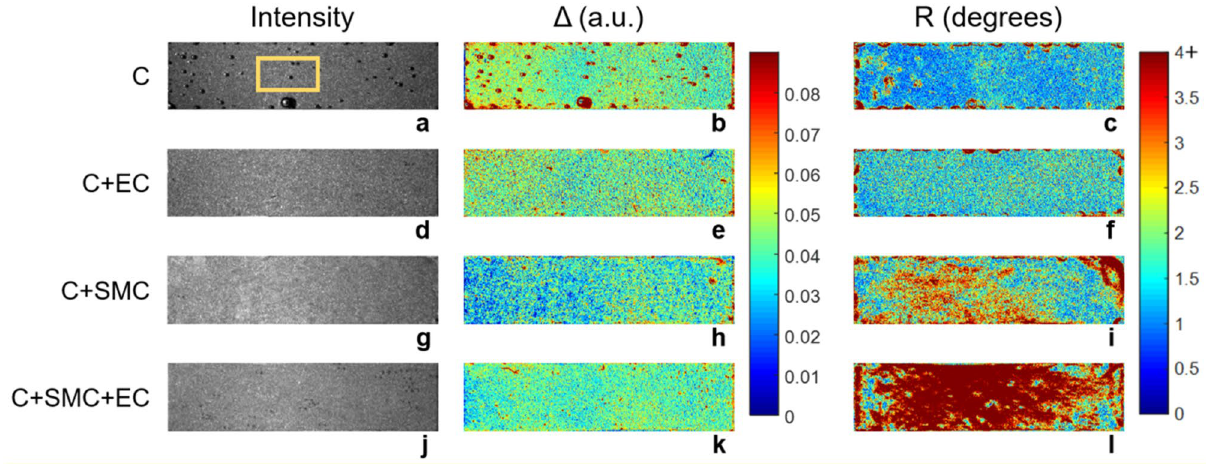
Figure 3. Intensity and polarimetric parameters of representative samples for each considered condition: ( a–c ) collagen hydrogel alone (C, sample 1), ( d–f ) collagen hydrogel with ECs on its top surface (E + EC, sample 1), ( g–i ) collagen hydrogel with embedded SMCs (C + SMC, sample 2), and ( j–l ) collagen hydrogel with embedded SMCs and ECs on its top surface (C + SMC + EC, sample 2). The first column shows the monochromatic unpolarized intensity image (arbitrary units), corresponding to the non-normalized m 11 coefficient of the measured Mueller matrix M S . The second and third columns show the parameters Δ and R, respectively. The dimensions of the imaged samples are 0.75 cm × 3